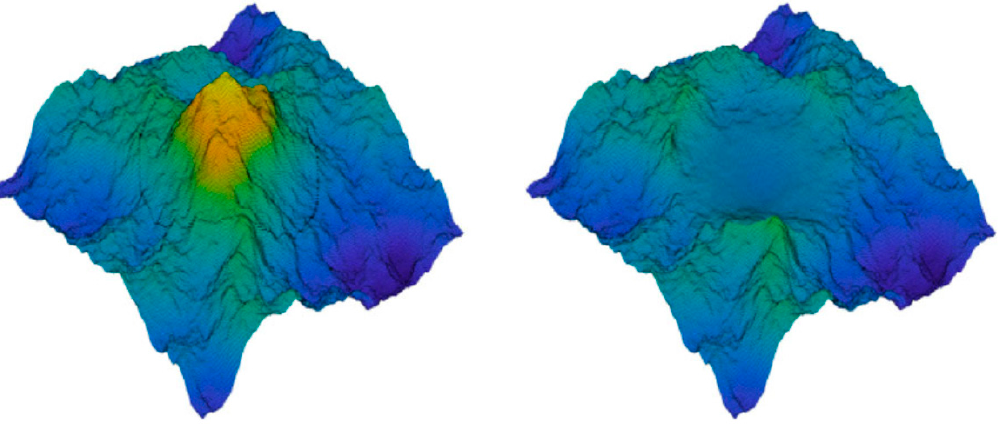
Figure 7. Normal contact between a rough surface and an elastic half-space using BEM: topography of a rough surface before and after detachment and disappearance of a wear particle. Taken from [82].